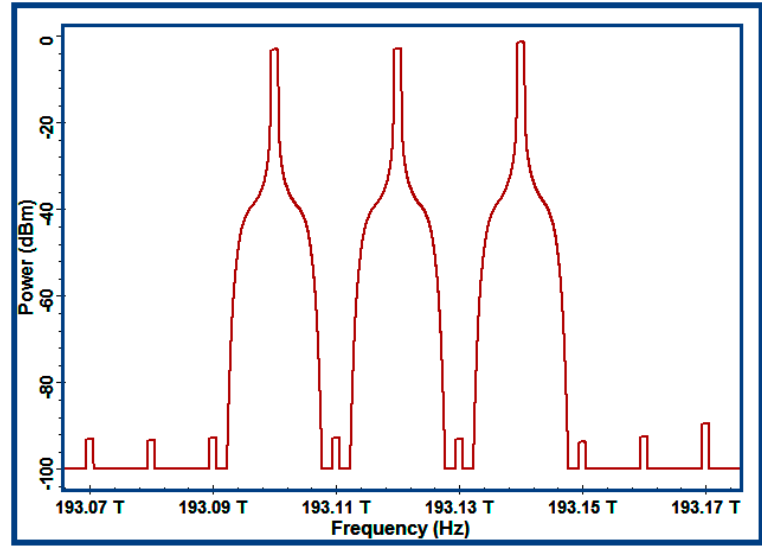
Figure 11. The tree pure optical sources in RRU.